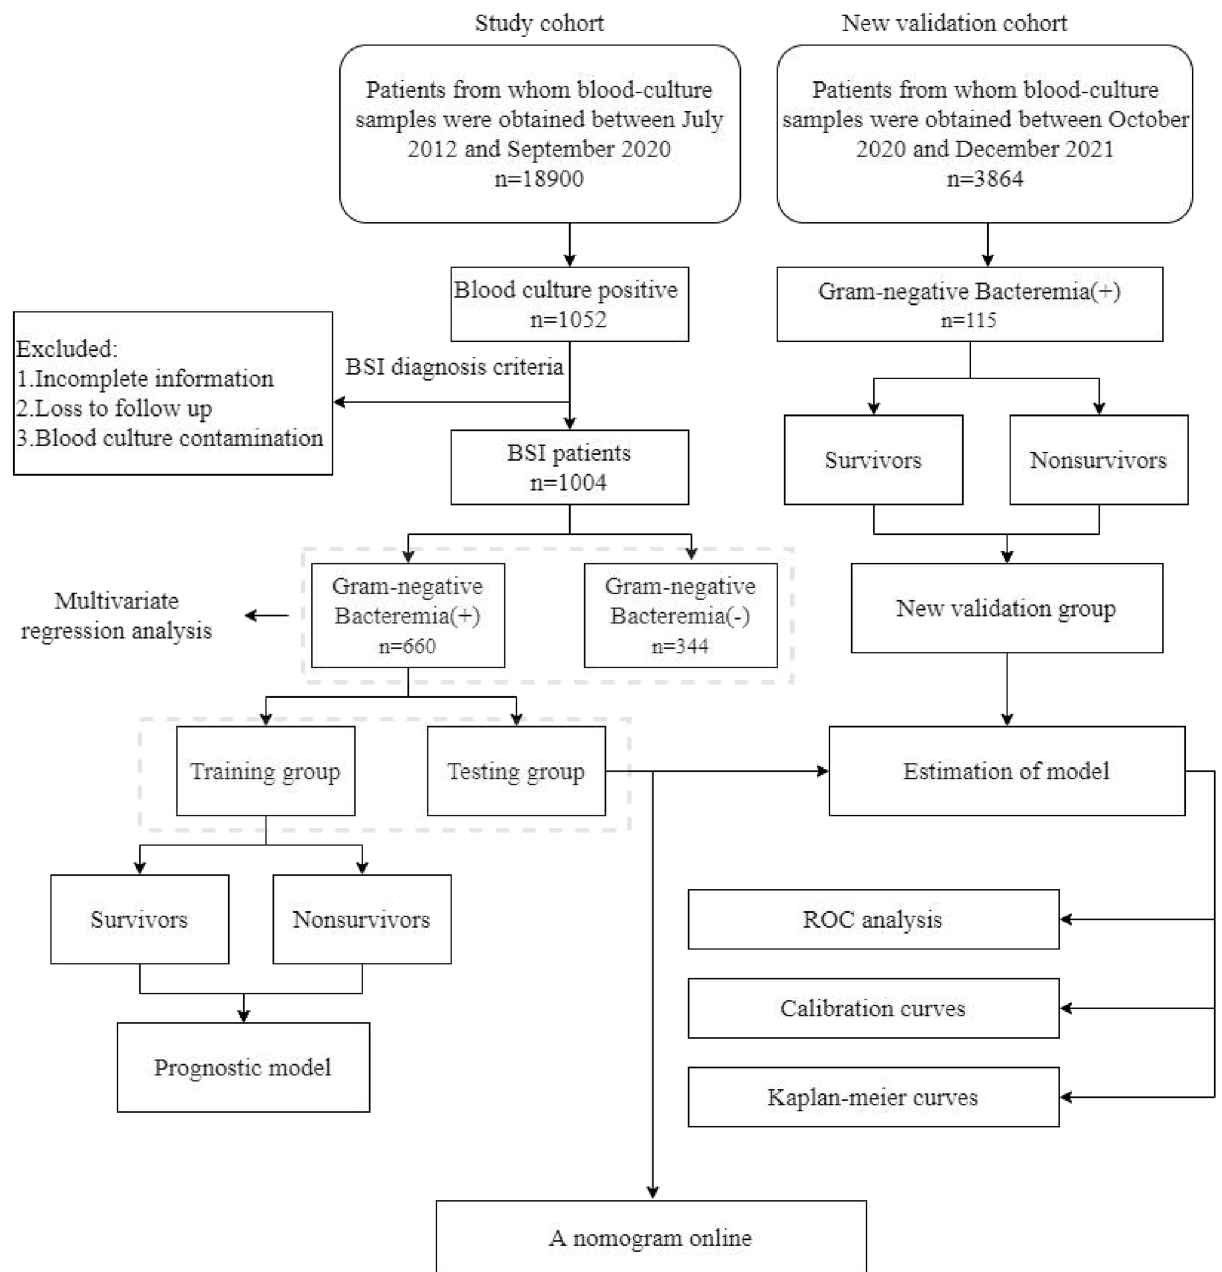
Figure 1. Study design. This research began with records of all patients whose blood-culture samples were obtained between July 2012 and September 2020. All participants were separated into training and testing cohort. And a new validation cohort were obtained between October 2020 and December 2021. A prognostic model was constructed using a training cohort estimated in testing and new validation cohorts. Finally, an online nomogram was generated based on the prognostic